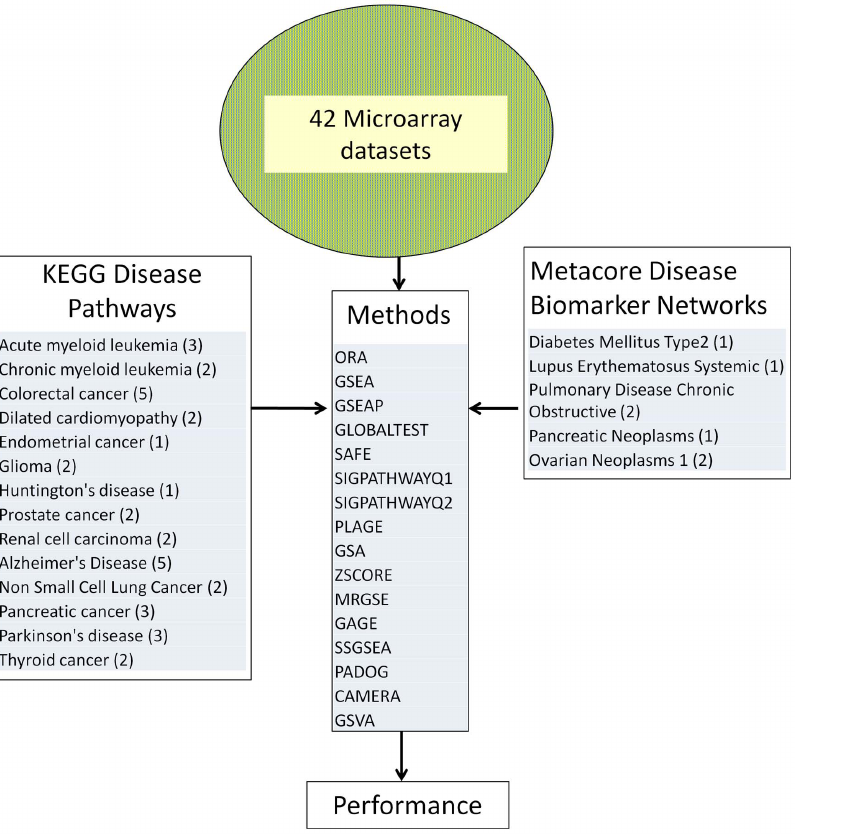
Figure 1. Procedure used to compare 16 gene set analysis methods. 42 microarray datasets were used, each studying a phenotype that has a corresponding KEGG or Metacore disease pathway, that we call target pathway. Each method was applied on each datasets and the p-value and rank of the target pathway in each dataset was used to compare the methods.